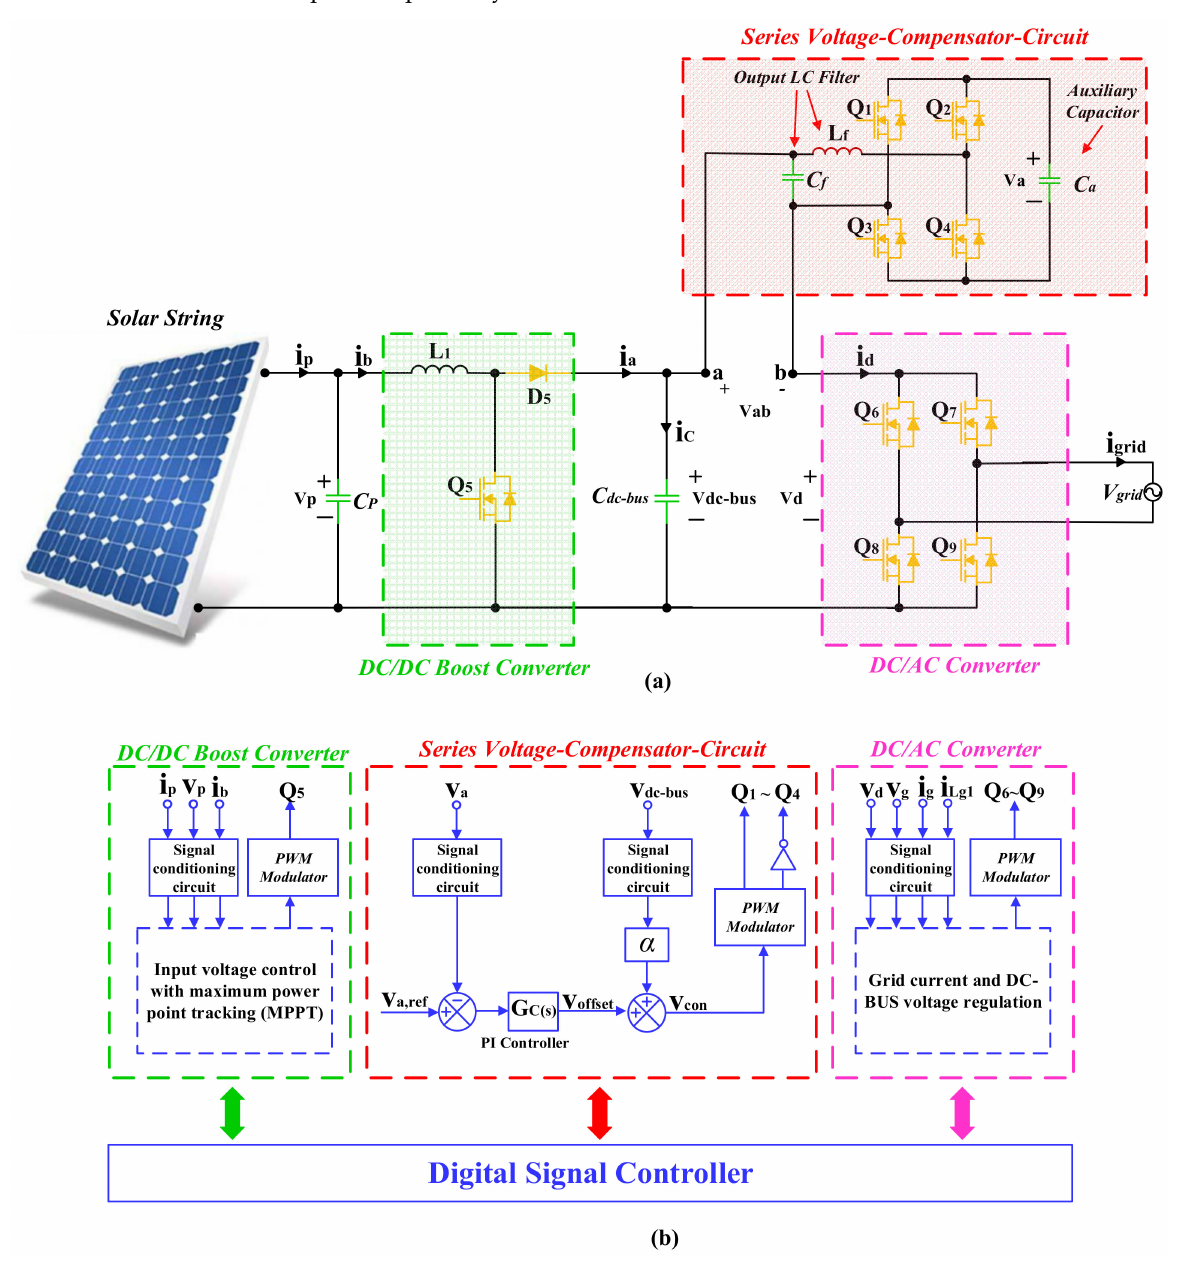
Figure 12. ( a ) Circuit diagram of a grid-tied solar inverter architecture with a series voltage compen- sator circuit; ( b ) Main controller interface structure (based on